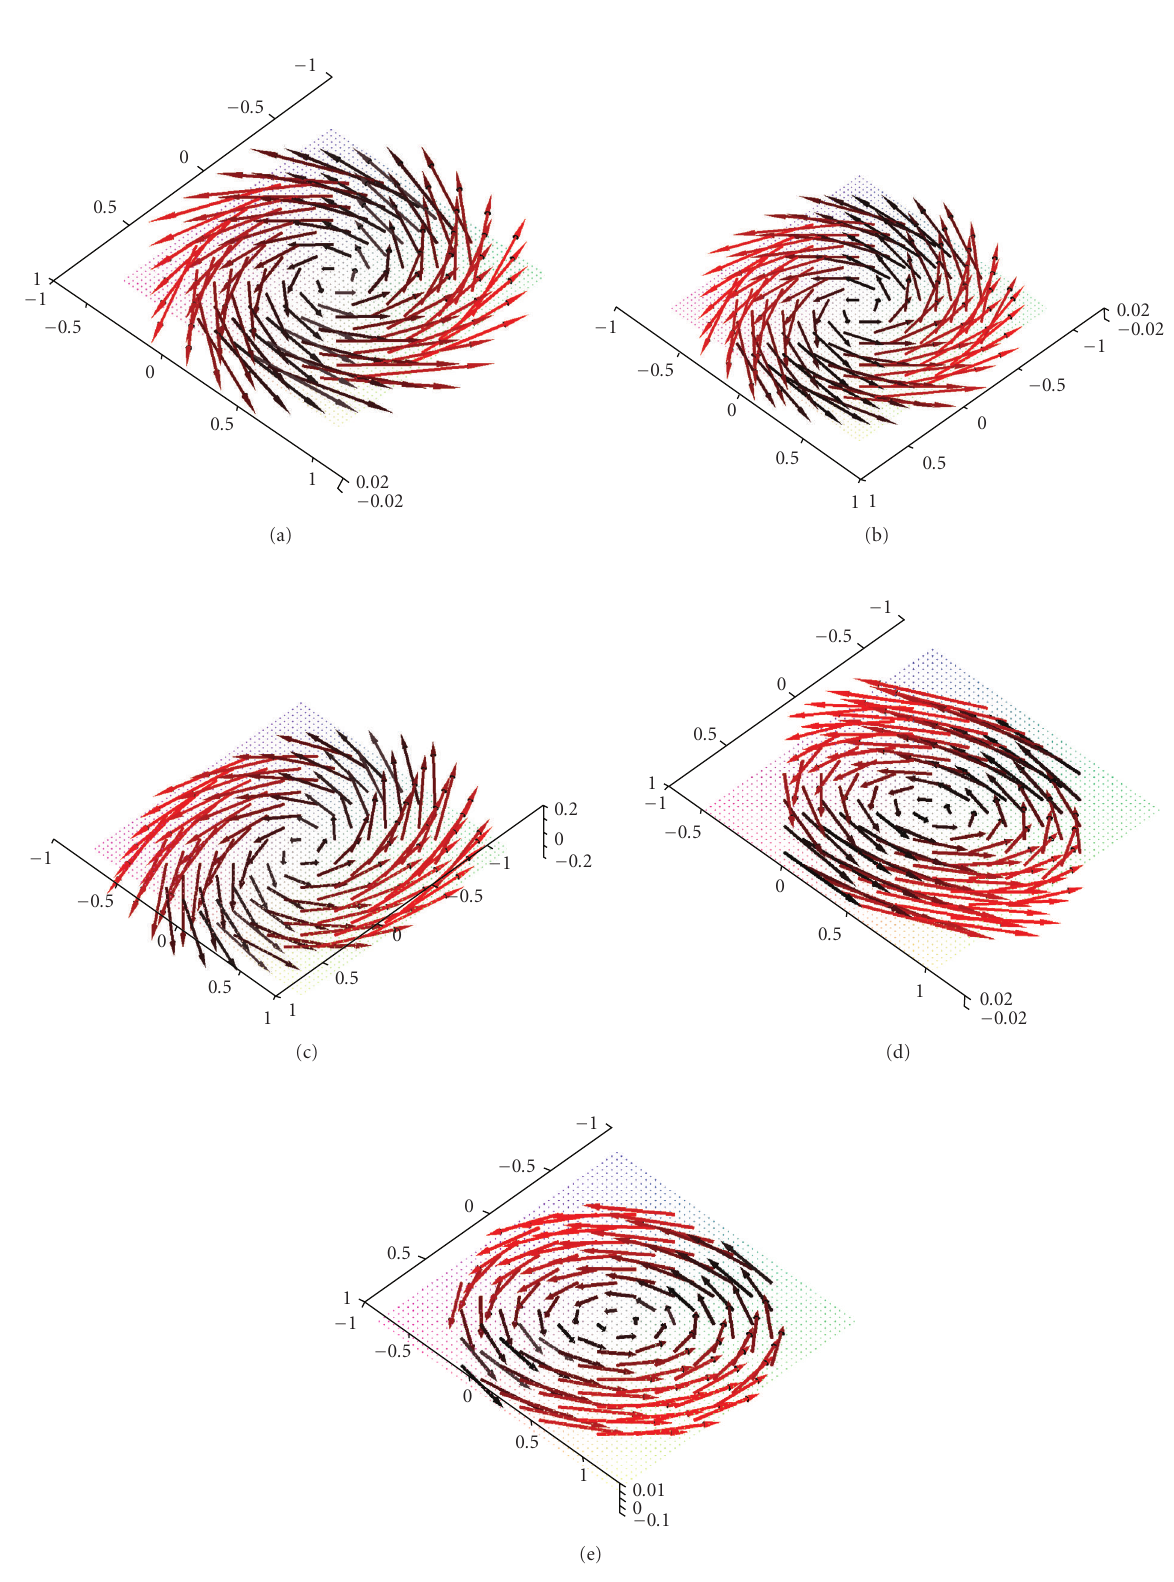
Figure 21: (a) Original vector field f ( x ) = ( − x 2 , x 1 ,0) (cid:9) . (b) Reconstruction with the described algorithm for γ = 0 . 00692 using one single circle in the plane { x 3 = 0 } . (c) Reconstruction with the described algorithm for γ = 0 . 00692 using circles in the planes { x 3 = 0 } and { x 1 = 0 } . (d) Reconstruction with the described algorithm for γ = 0 . 00692 using circles in the planes { x 3 = 0 } and { x 2 = 0 } . (e) Reconstruction with the described algorithm for γ = 0 . 00692 using three orthogonal circles in the planes { x i = 0 } , i =